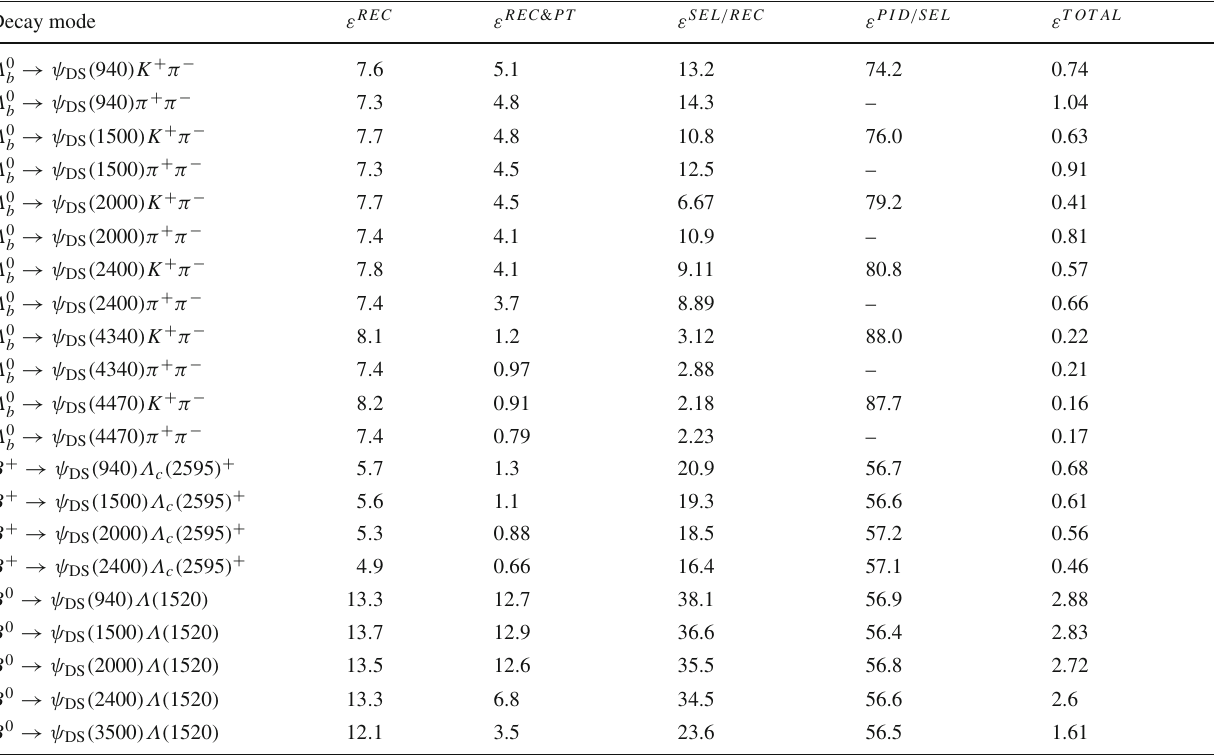
Table 2 Reconstruction and selection efficiencies for the signal decays describedinthetext,asobtainedfromfastsimulation,whereweaddeda posteriori a 98% efficiency per track to account for multiplicity effects. Geometry of the detector is considered within ε REC . The efficiencies are shown in %. The ε REC & PT efficiency implies that all tracks have been required to have a transverse momentum greater than 800 MeV / c , except for B + → ψ DS Λ c ( 2595 ) + decays, where this requirement is